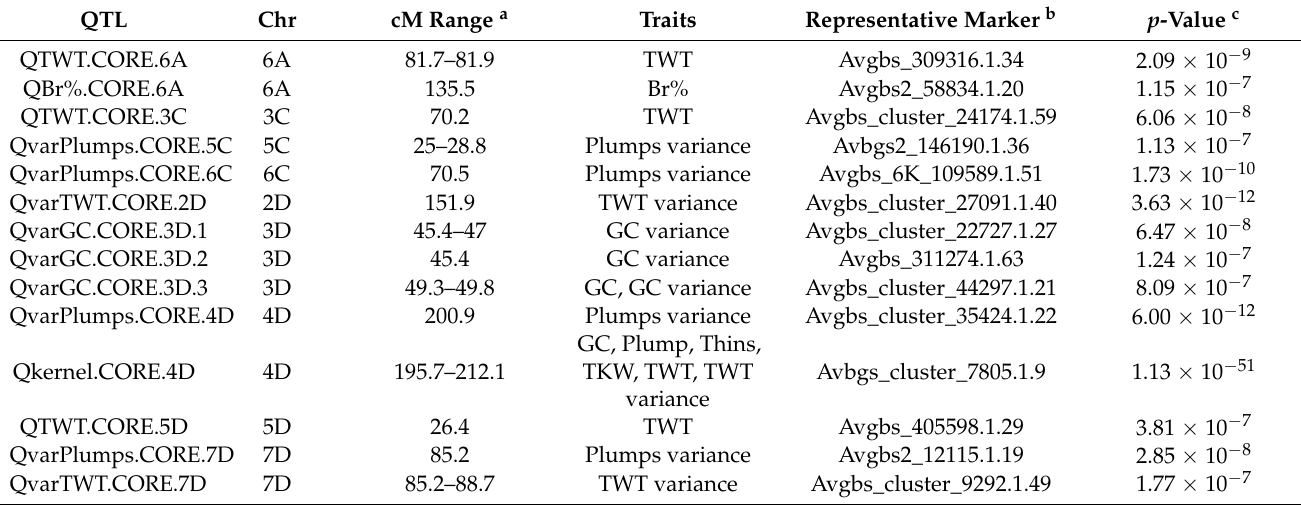
Table 3. Summary of mapped quantitative trait loci associated with milling trait means and variances across location years. Consensus linkage map location, trait(s) associated at p ≤ 1.41 × 10 − 6 and the name and p -value of the representative marker are indicated. p -values for the representative marker from analyses of all traits are provided in Supplemental Table